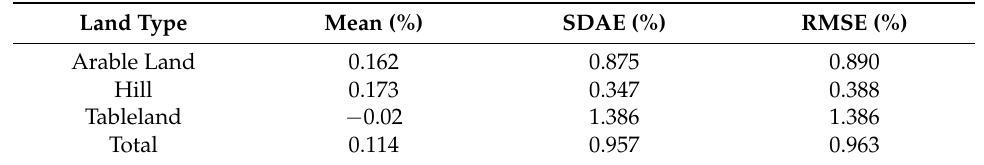
Figure 12. Accuracy evaluation of the estimated results: ( a ) the comparison between the estimation value and the in situ measurement; ( b ) the statistical analysis of the absolute errors of soil moisture estimation; ( c ) the absolute errors of soil moisture estimation in each in situ site with different topographical conditions. Table 3. The absolute errors statistic of soil moisture estimations on different topographical